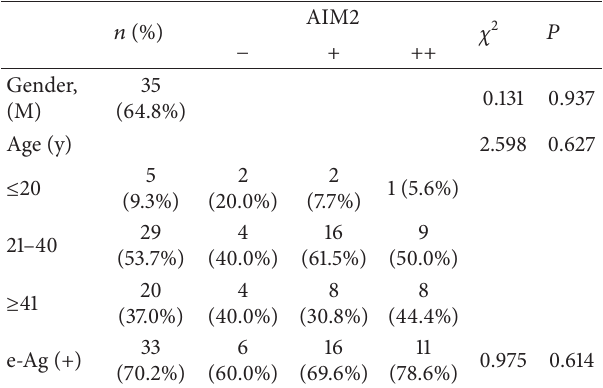
Table 4: Expression of AIM2 was negatively correlated with HBV antigen deposition in HBV-GN kidney